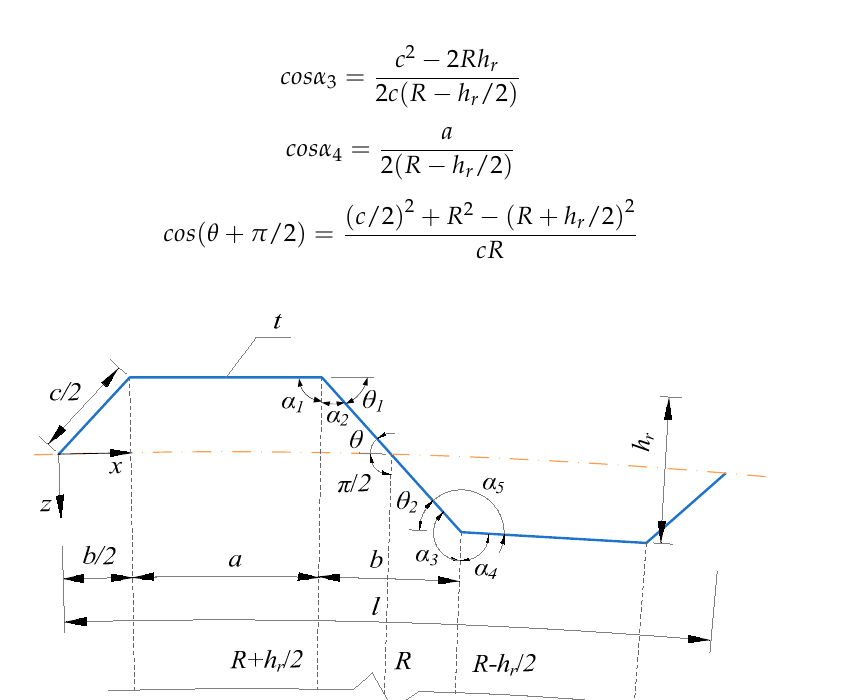
Figure 6. Longitudinal section of a single wavelength PCCSW.